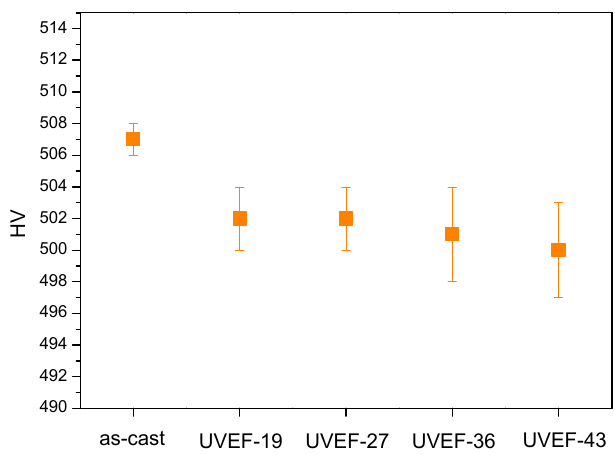
Figure 7. Comparison of the microhardness of the as ‐ cast and UVEF ‐ treated samples.